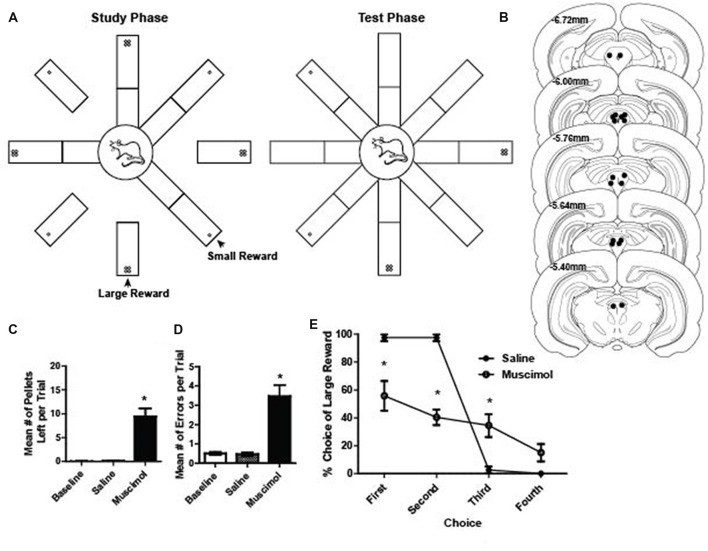
(A) Schematic illustration of the radial arm maze task. During the study phase, one arm of the maze was raised at a time until four arms were visited by the rat. Large rewards (four sugar pellets) were placed on every other arm of the maze. During the test phase, all eight arms of the radial maze were raised and rats were free to visit any arm of their choice to collect the rewards from the remaining four arms. (B) Reconstruction of bilateral cannulae tip placement relative to Bregma (N = 9). (C) Mean number of pellets per trial that were left on the maze during baseline, saline and muscimol trials. A total of 20 pellets were available per trial. There were significantly more pellets left during muscimol trials compared to baseline and saline (dependent t test, saline vs. muscimol normalized to baseline pellets; t(1,17) = 5.59, p < 0.001). (D) Mean number of errors per trial during baseline, saline and muscimol conditions. There were significantly more errors on muscimol trials compared to baseline and saline (dependent t test, saline vs. muscimol normalized to baseline errors, t(1,17) = 5.46, p < 0.001). (E) Preference for visiting the large reward arms first during the test phase of a trial for saline- and muscimol-treated rats. Muscimol-treated rats showed a significantly reduced preference to collect large rewards on the first and second free choice when compared to saline-treated rats (two-way repeated measures ANOVA, main effect of treatment: F(1,7) = 23.19, p < 0.001; main effect of choice order: F(3,21) = 61.47, p < 0.001; significant interaction between treatment and choice order: F(3,21) = 23.44, p < 0.001). All error bars represent ±SEM. *p ≤ 0.05.